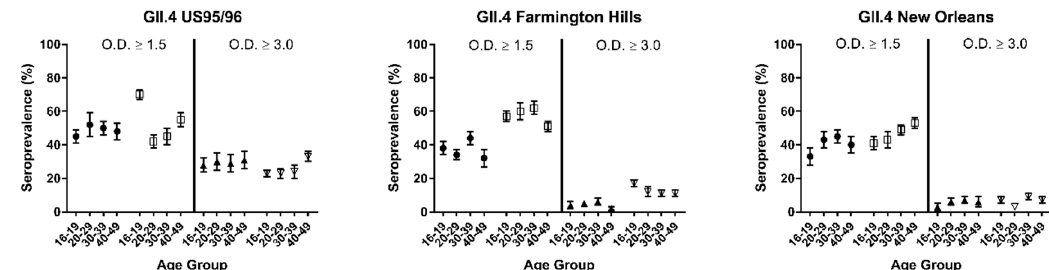
Figure 2. Overall seroprevalence and serologic evidence of recent infection stratified by GII.4 antigen, age group, and NHANES study cycle. Overall seroprevalence defined as OD ≥ 1.5. Evidence of recent infection defined as OD ≥ 3.0. Closed circles, 1999–2000 and open circles, 2003–2004.